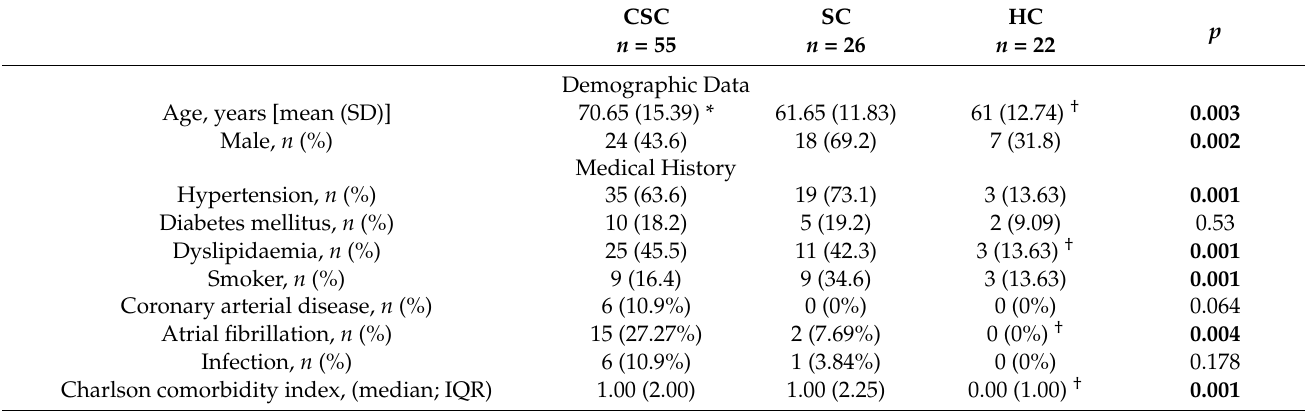
Table 1. Demographic data, medical history, and stroke data at